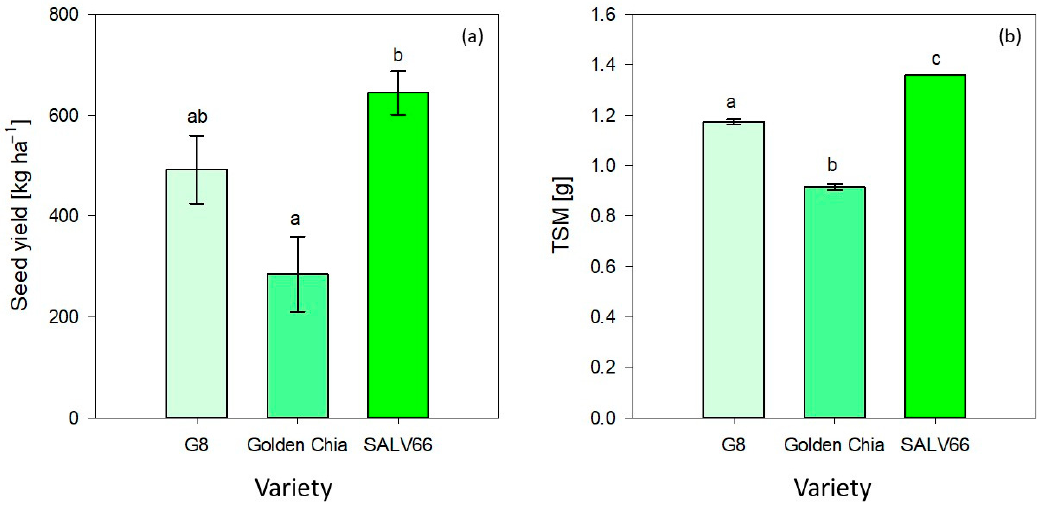
Figure 4. Seed yield (kg ha − 1 ). ( a ) and thousand seed mass (TSM) (g) ( b ) of the three Salvia varieties (G8, Golden Chia, and SALV66) cultivated at Ihinger Hof in 2018. Means which share a common lowercase letter are not significant at α = 0.05. ( n = 3, α = 0.05, means ± standard error bars based on model [3]).